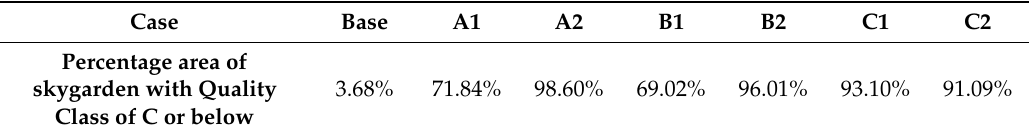
Table 6. Percentage area of skygarden within quality class of C; (a1) railing 1.5 m, (a2) railing 2 m,